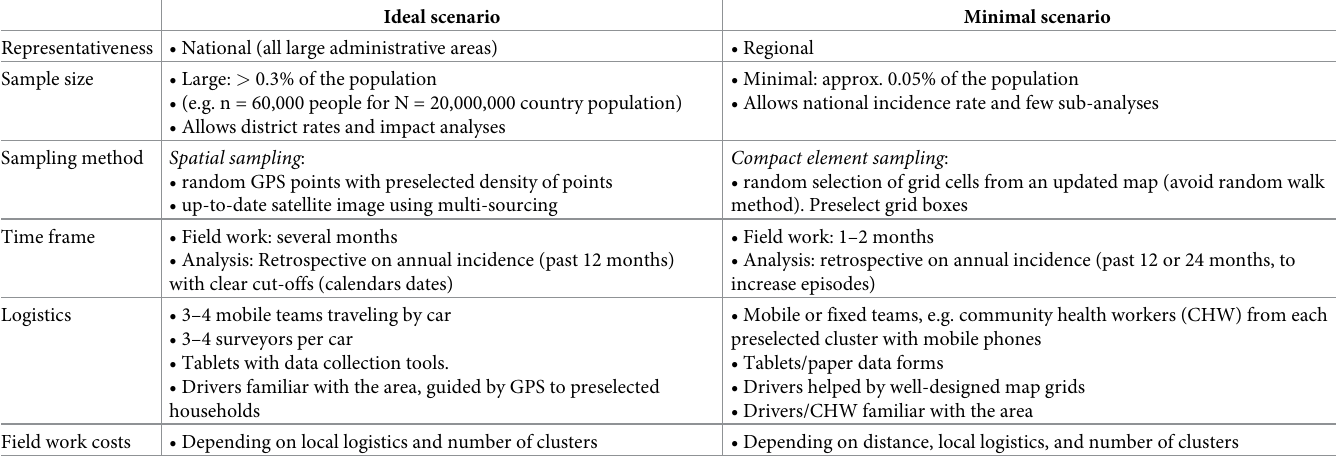
Table 2. Structural modules for developing snakebite multi-cluster random